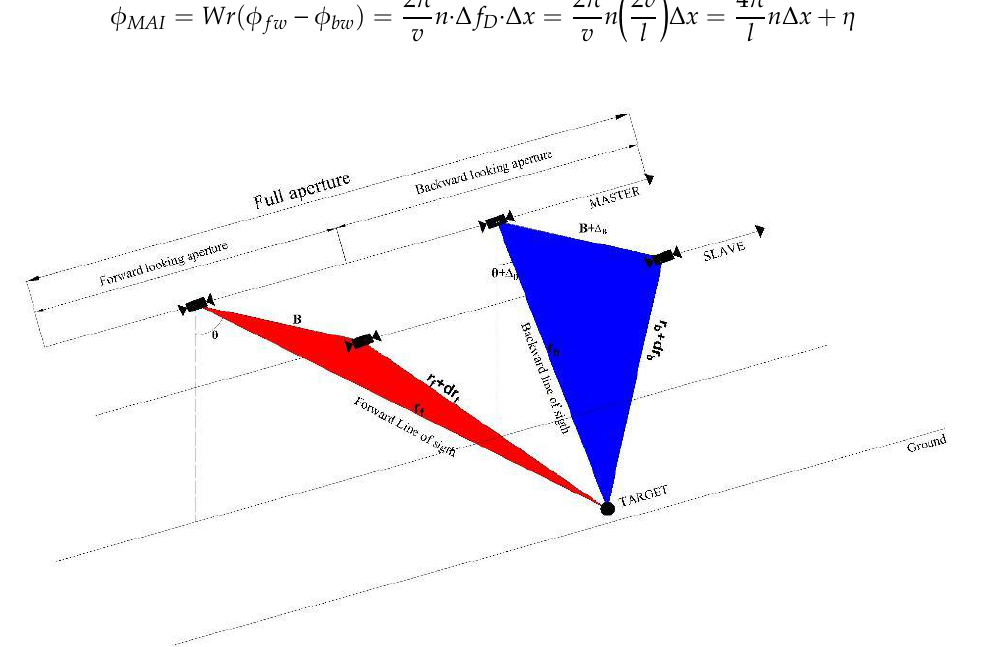
Figure 6. Multiple aperture interferometry geometry acquisition. The target on the ground is observed